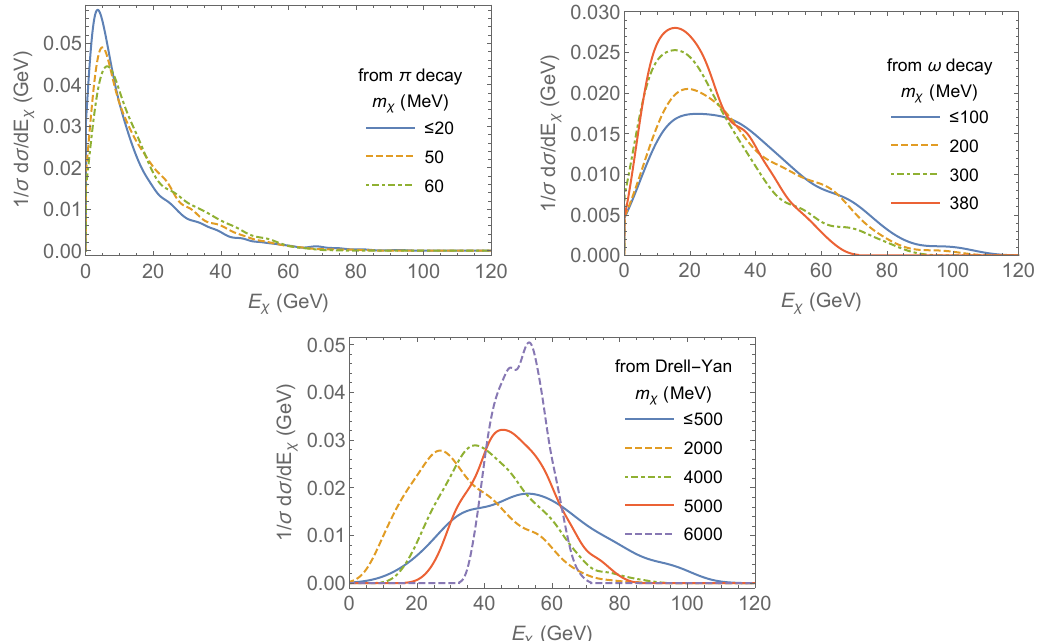
Figure 3 . The energy distribution of millicharged particles that are accepted by ArgoNeuT from various sources and for di(cid:11)erent masses. In each plot, mCP masses are chosen so that the respective production mode is